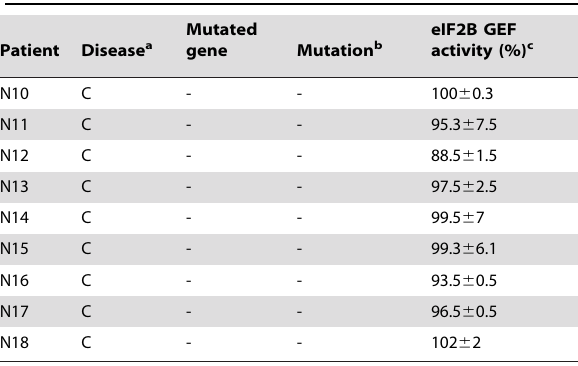
Table 2. eIF2B GEF activity measured in lymphoblasts from the 38 leukodystrophic patients (19 OL and 19 CACH/VWM- like) and the 18